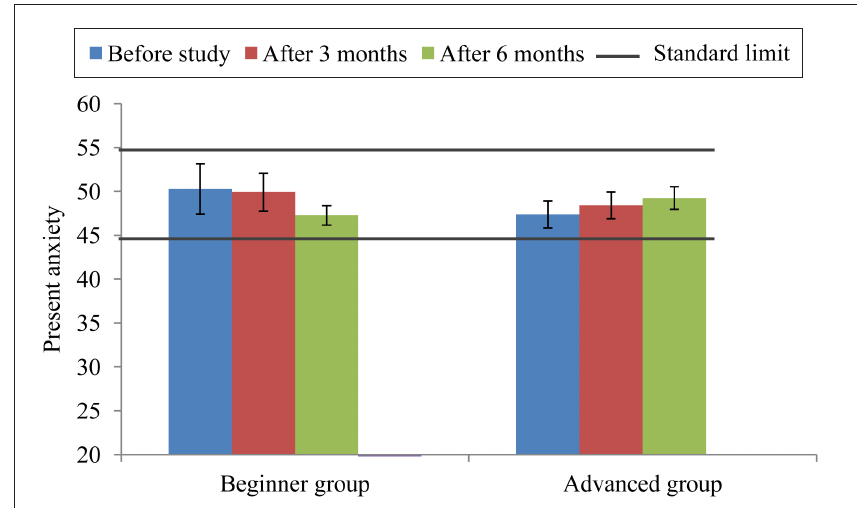
Figure 6. Present anxiety in the beginner and advanced yoga